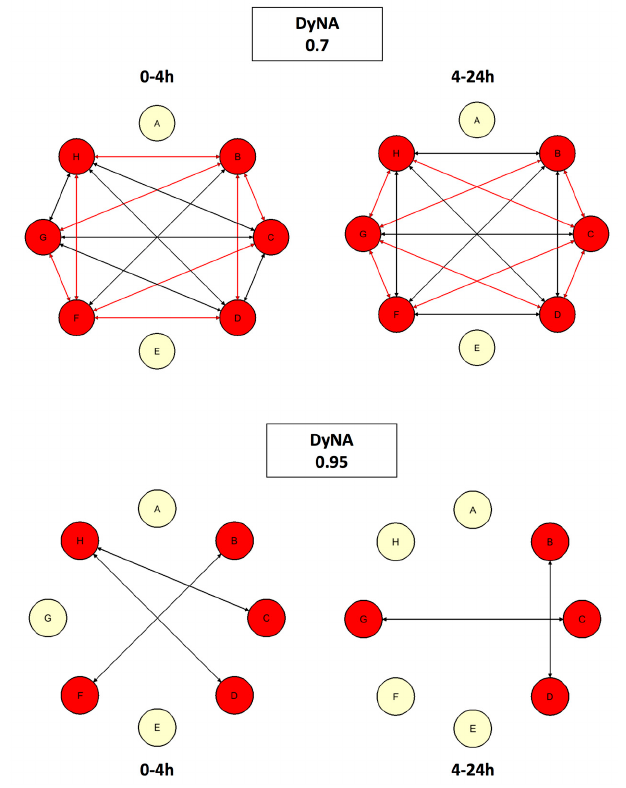
Figure 3. DyNA using example data: The DyNA algorithm was run for two different time intervals (0–4 h, 4–24 h) and two different correlation thresholds (0.7, 0.95). In all networks, the algorithm links variables that exhibit both positive (black) and negative (red) correlations in a given time interval. Variables that do not exhibit change (A and E) are correctly left unlinked to the other, changing variables by the algorithm.